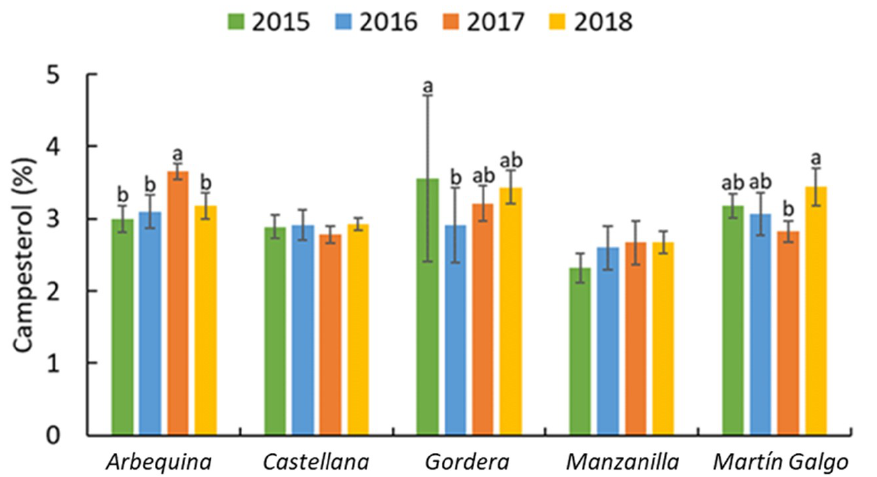
Figure 5. Campesterol content of the monovarietal oils produced with the varieties of olives grown in the Aceite de la Alcarria PDO during the four consecutive olive crop seasons under study. Mean values of the samples elaborated in each season. Different letters within each variety indicate significant differences among seasons (Duncan test, p < 0.05).